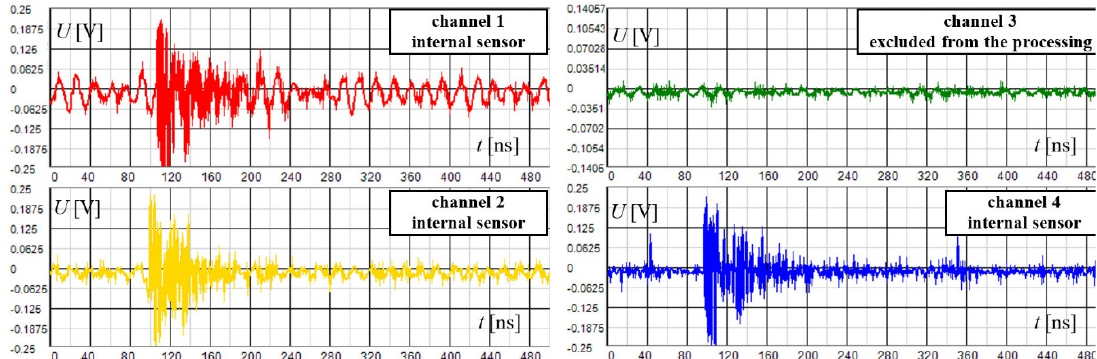
Figure 22. The waveforms of the artificial signal acquired using the DDA method; the signal of the external sensor on channel 3 is excluded from processing and displaying.